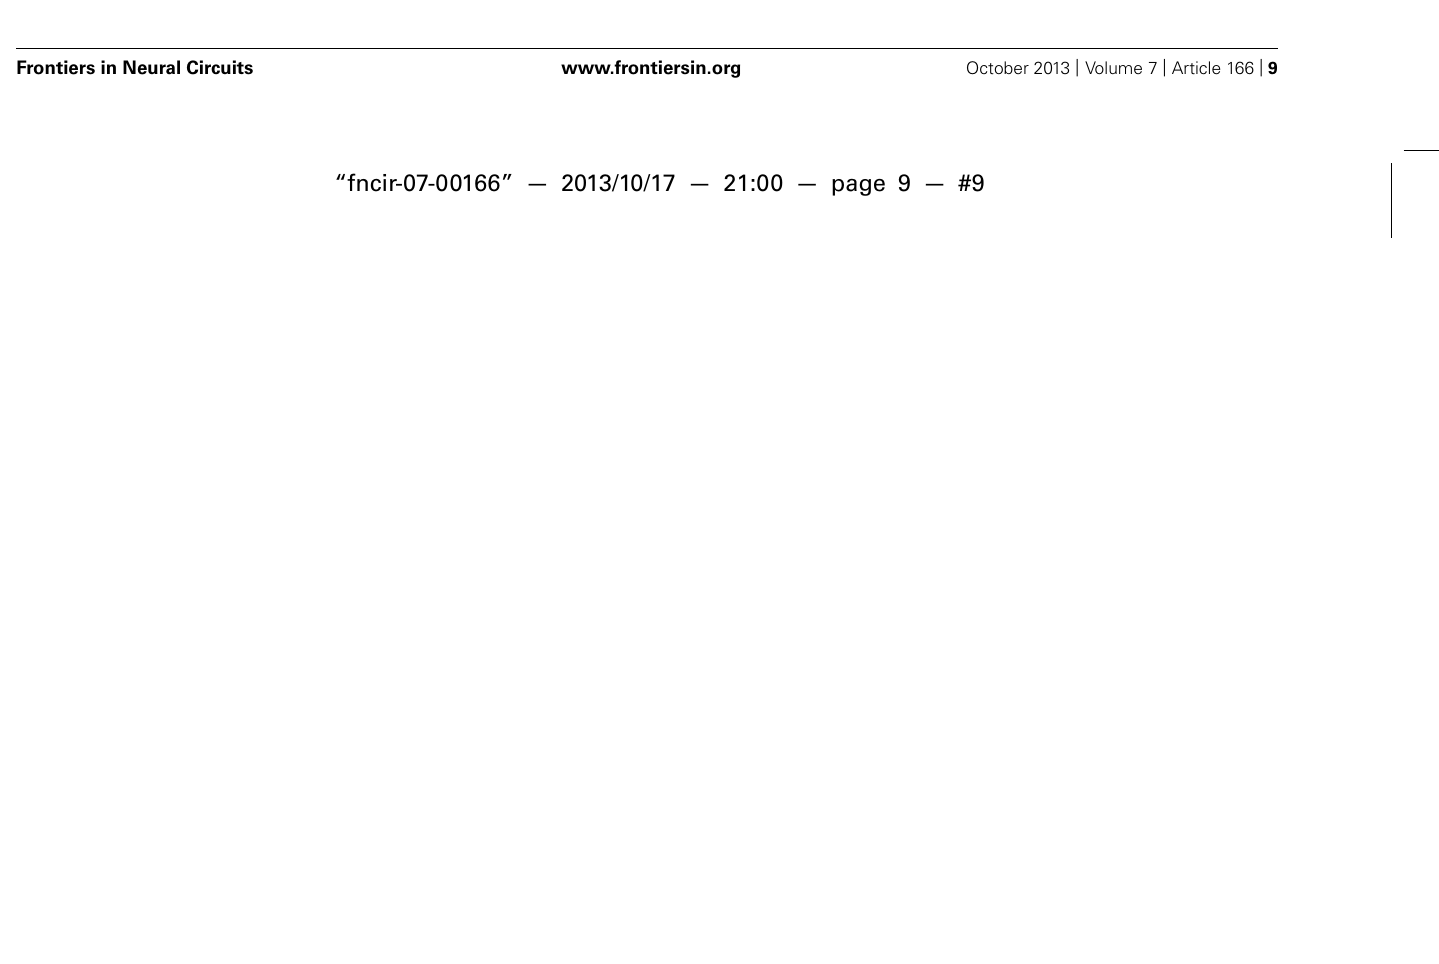
FIGURE 5 | Median correlations. Examples with correlation values around the median value across our data set are shown for different frequency regions for the three vocalizations. The median correlation value is 0.75 for TSV, 0.87 for BH, and 0.86 for BT.